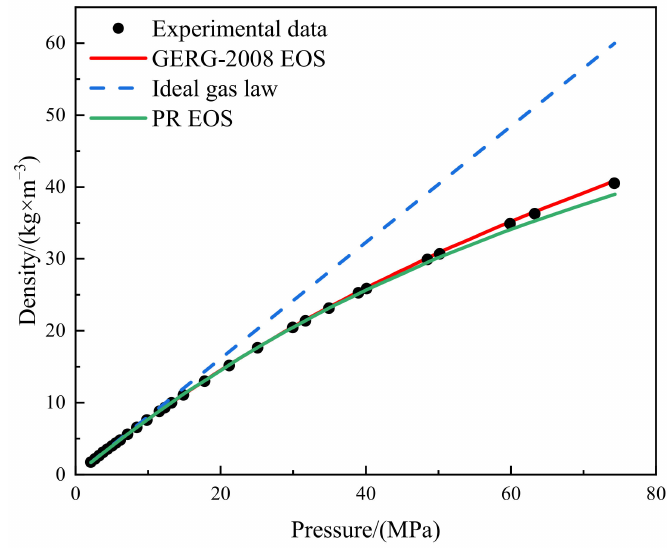
Figure 1. Comparison between different equations of state and experimental hydrogen thermophysi- cal